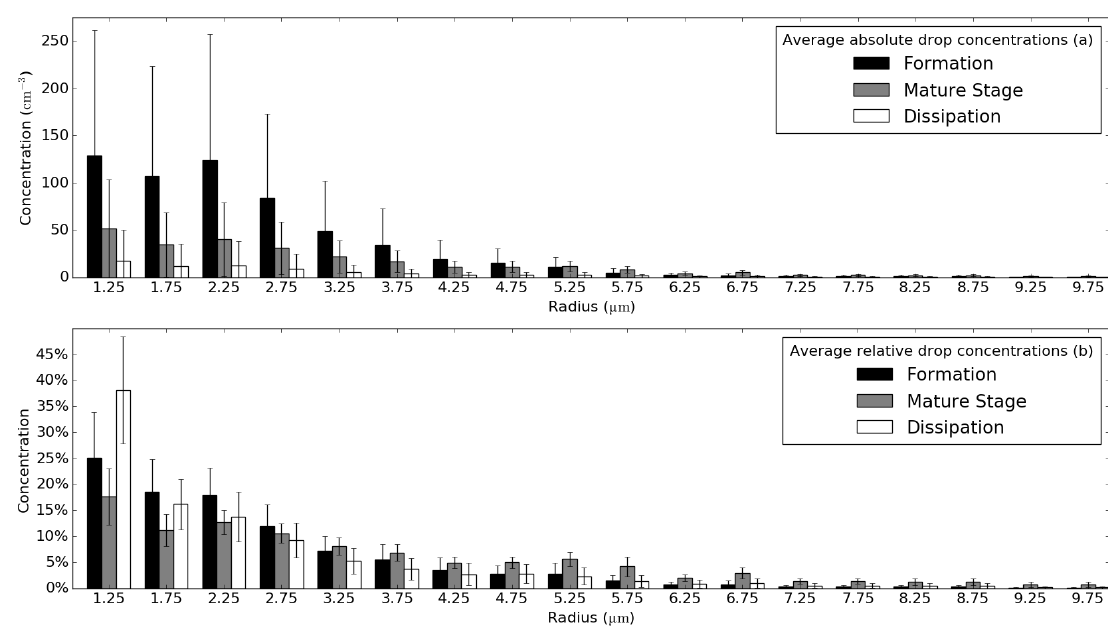
Figure 7. Average spectra (over all three fog events): ( a ) Absolute drop concentrations and ( b ) relative drop